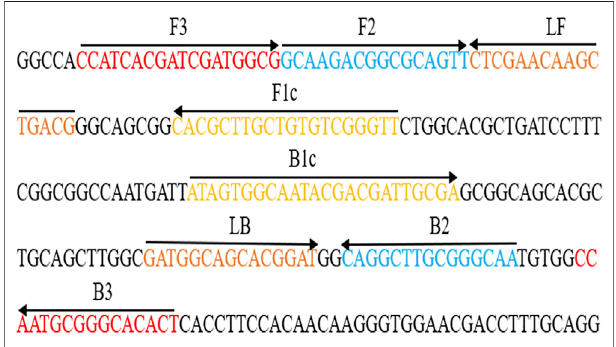
FIGURE 2 | Primers speci fi c to BruAb2_0168 gene of B. abortus used for the B. abortus -LAMP-LFIA assay. The sequence and location of the BruAb2_0168 gene was performed to design B. abortus -LAMP primers. Primer Ba -FIP contained F1c and F2; primer Ba -BIP contained B1c and B2.Thedirectionofarrows indicatedtheprimerfrom5 ′ to3 ′ .LFIA,lateral fl ow immunoassay biosensor; LAMP, loop-mediated isothermal ampli fi cation.